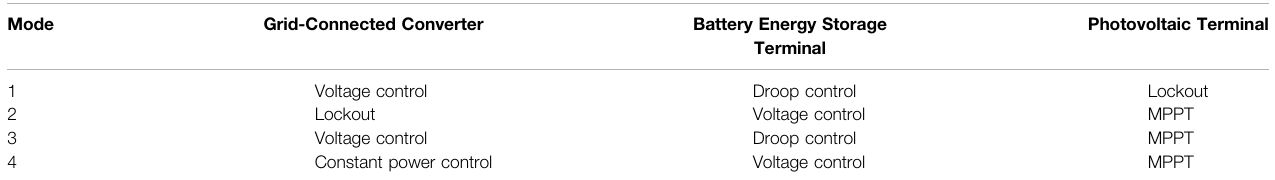
TABLE 1 | Operation modes of the DC microgrid